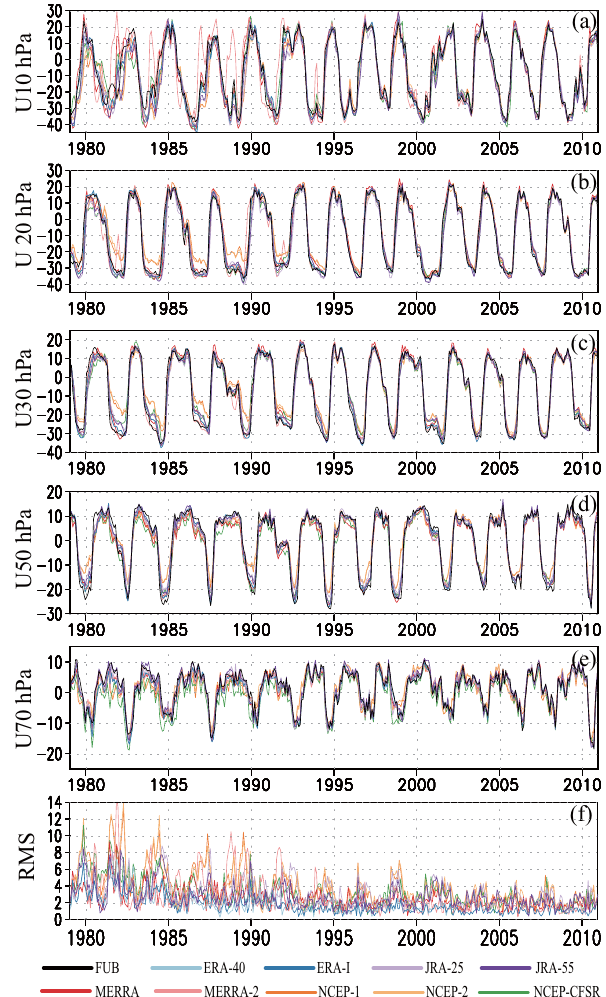
Figure 2. Time variations of the zonal wind over Singapore at (a) 10, (b) 20, (c) 30, (d) 50, and (e) 70hPa for FUB observa- tion (black), ERA-40 (light blue), ERA-I (blue), JRA-25 (light pur- ple), JRA-55 (purple), MERRA (red), MERRA-2 (pink), NCEP- 1 (orange), NCEP-2 (yellow), and NCEP-CFSR (green); (f) Root mean square differences between the FUB and each reanalysis zonal wind, averaged at